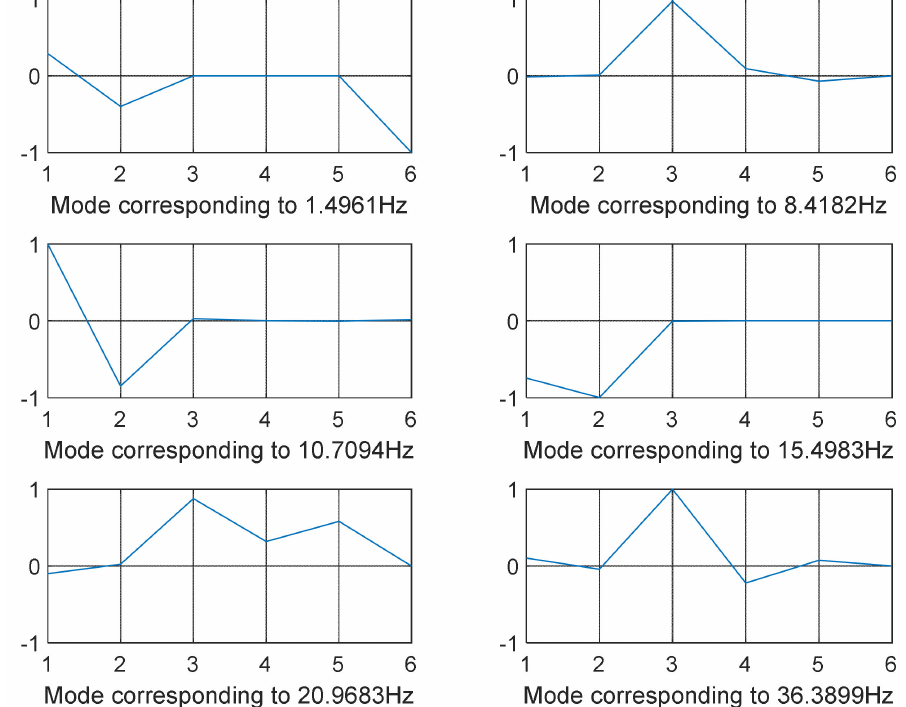
Figure 9. GWO-optimized mode shapes 1–6 (12-DOF model—combined